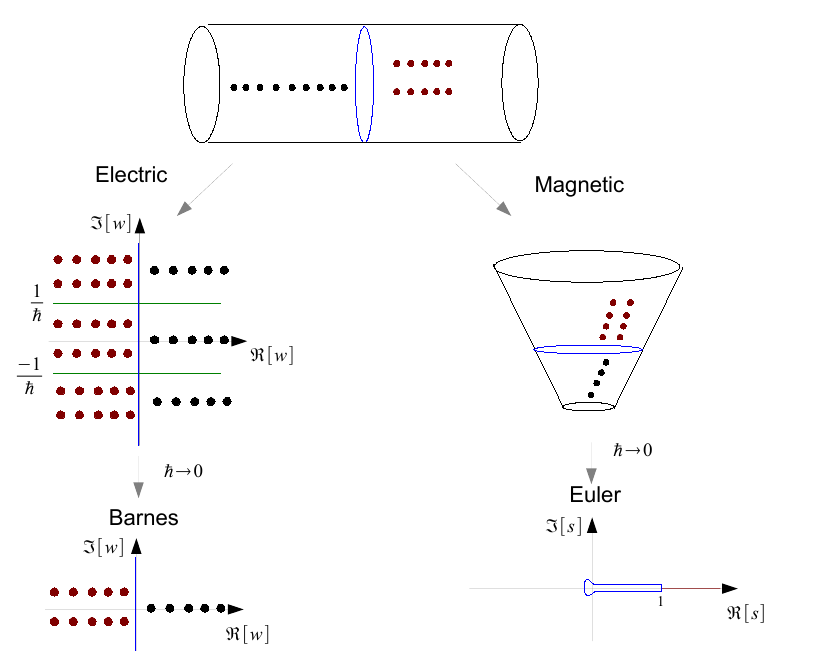
Figure 9 . Reduction of the integration contours in the mirror pair of T [SU(2)] theories in the ~ ! 0